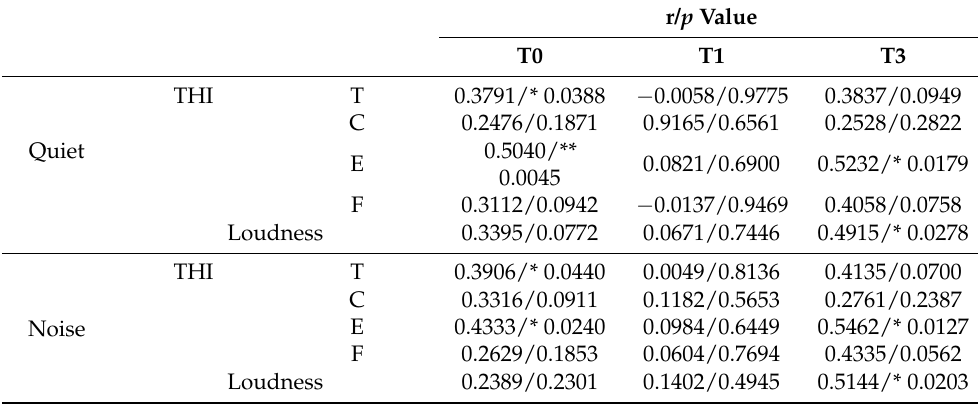
Table 4. Correlations of THI scores (total and all 3 subscales) and loudness with reaction time in quiet conditions and with noise before treatment (T0), 1 month after treatment (T1) and 3 months after treatment (T3). THI = Tinnitus Handicap Inventory, T: total score; C: catastrophic, E: emotional; F: functional subscales; r: Spearman correlation coefficient; * p < 0.05, ** p < 0.01. r/ p